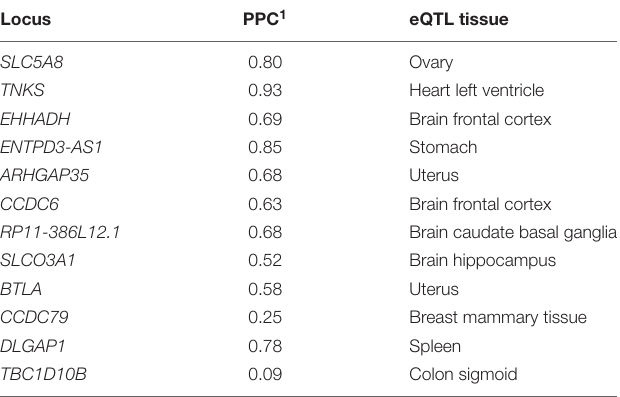
TABLE 4 | Colocalization of Köttgen SUA1 signal and SUA1 trans -eQTL signals. Locus